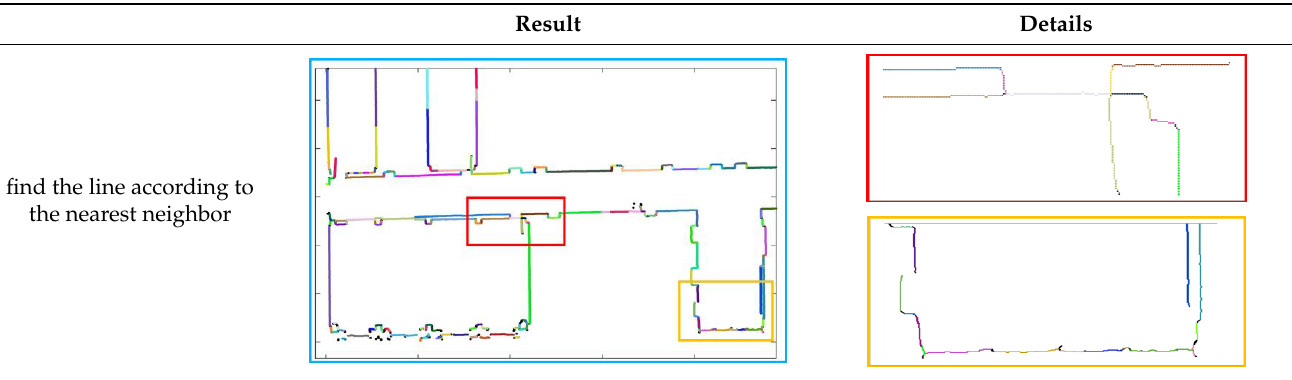
find the line according to the nearest neighbor